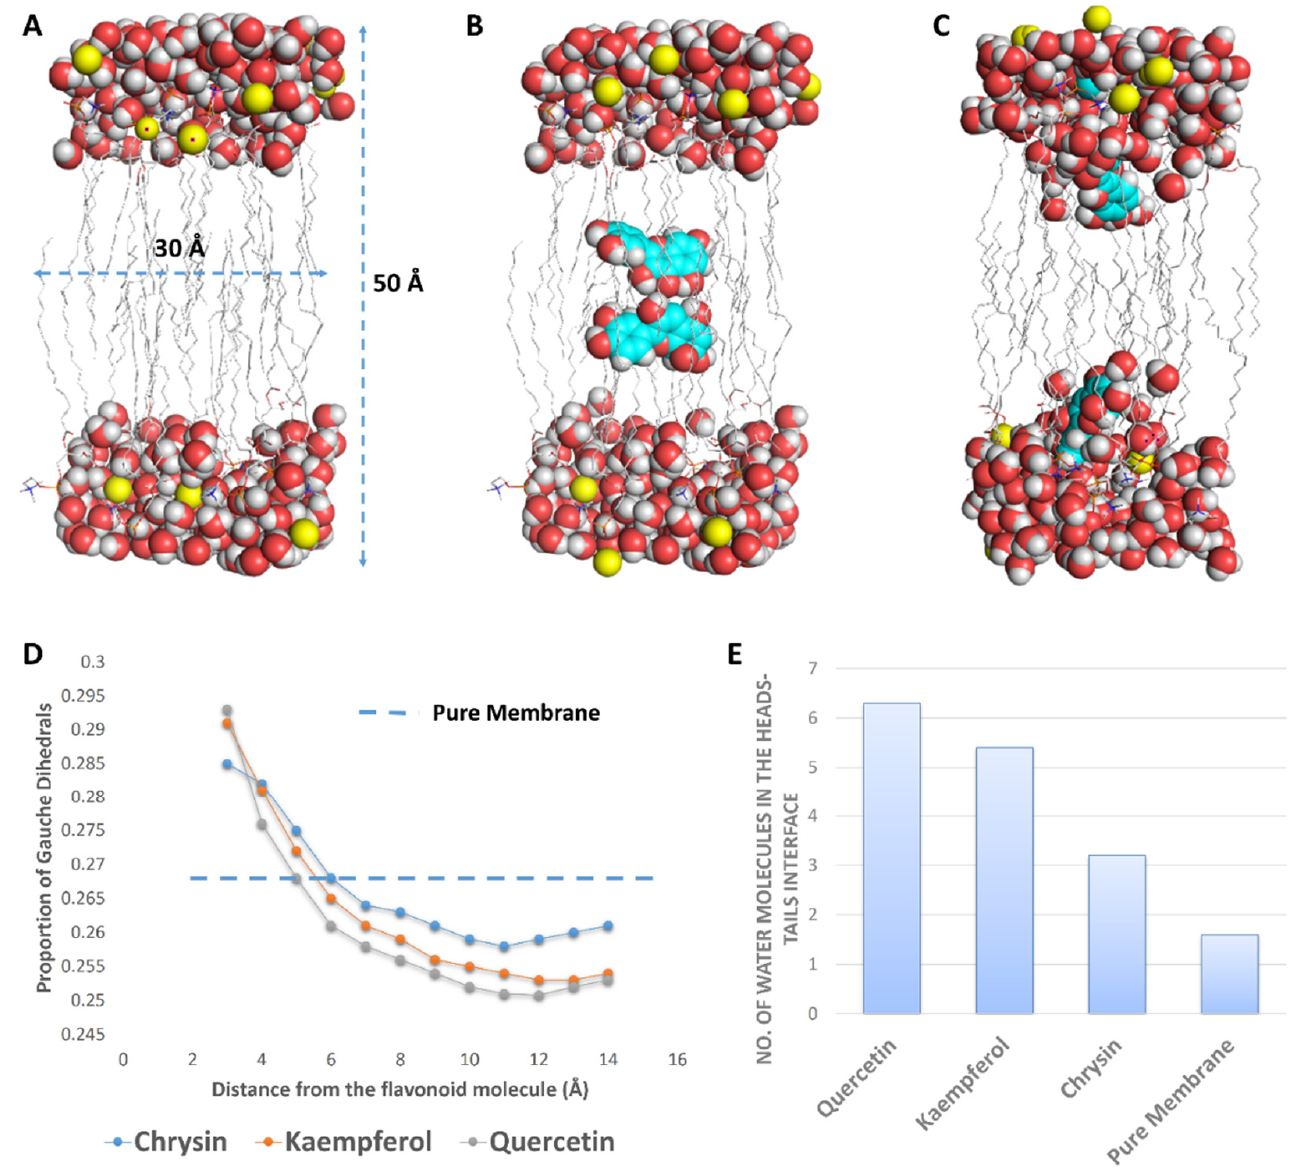
Figure 8. ( A ) The lipid bilayer system used for the MDS. ( B ) The lipid bilayer system with two molecules of quercetin at the beginning of a 100 ns MDS. ( C ) The lipid bilayer system at the end of 100 ns of MDS, where each quercetin molecule was stabilized at the head–tail interface. ( D ) Proportion of gauche dihedrals on lipid tail carbon atoms as a function of the lipid’s distance from each flavonoid molecule. ( E ) Number of water molecules per lipid molecule at the head–tail interface. Third, we studied the binding mode of each flavonoid inside the active site of E. coli ’s Gyr-B to rationalize their inhibitory effects. Quercetin, kaempferol, and chrysin achieved convergent docking scores with Gyr-B’s active site ( − 9.5, − 9.5, and − 9.3 kcal/mol). Addi- tionally, they took an orientation and exhibited molecular interactions inside the active site that were very close to that of the co-crystalized inhibitor (Figure 9). Being rich in hydroxyl groups, quercetin was able to establish a network of H-bonds with ASP-73, GLY- 77, GLY-101, LYS-103, ARG-136, and THR-165. Furthermore, it established a number of hydrophobic interactions with ILE-78, PRO-79, and ILE-94. Both kaempferol and chrysin exhibited the same interactions, except for the H-bond with ARG-136. To further validate these docking results, all of these binding poses were subjected to 50 ns MDS. Both quer- cetin and kaempferol were able to keep their binding orientation with low deviations (RMSD ~1.5 Å), while chrysin deviated more from its docking pose, with an average